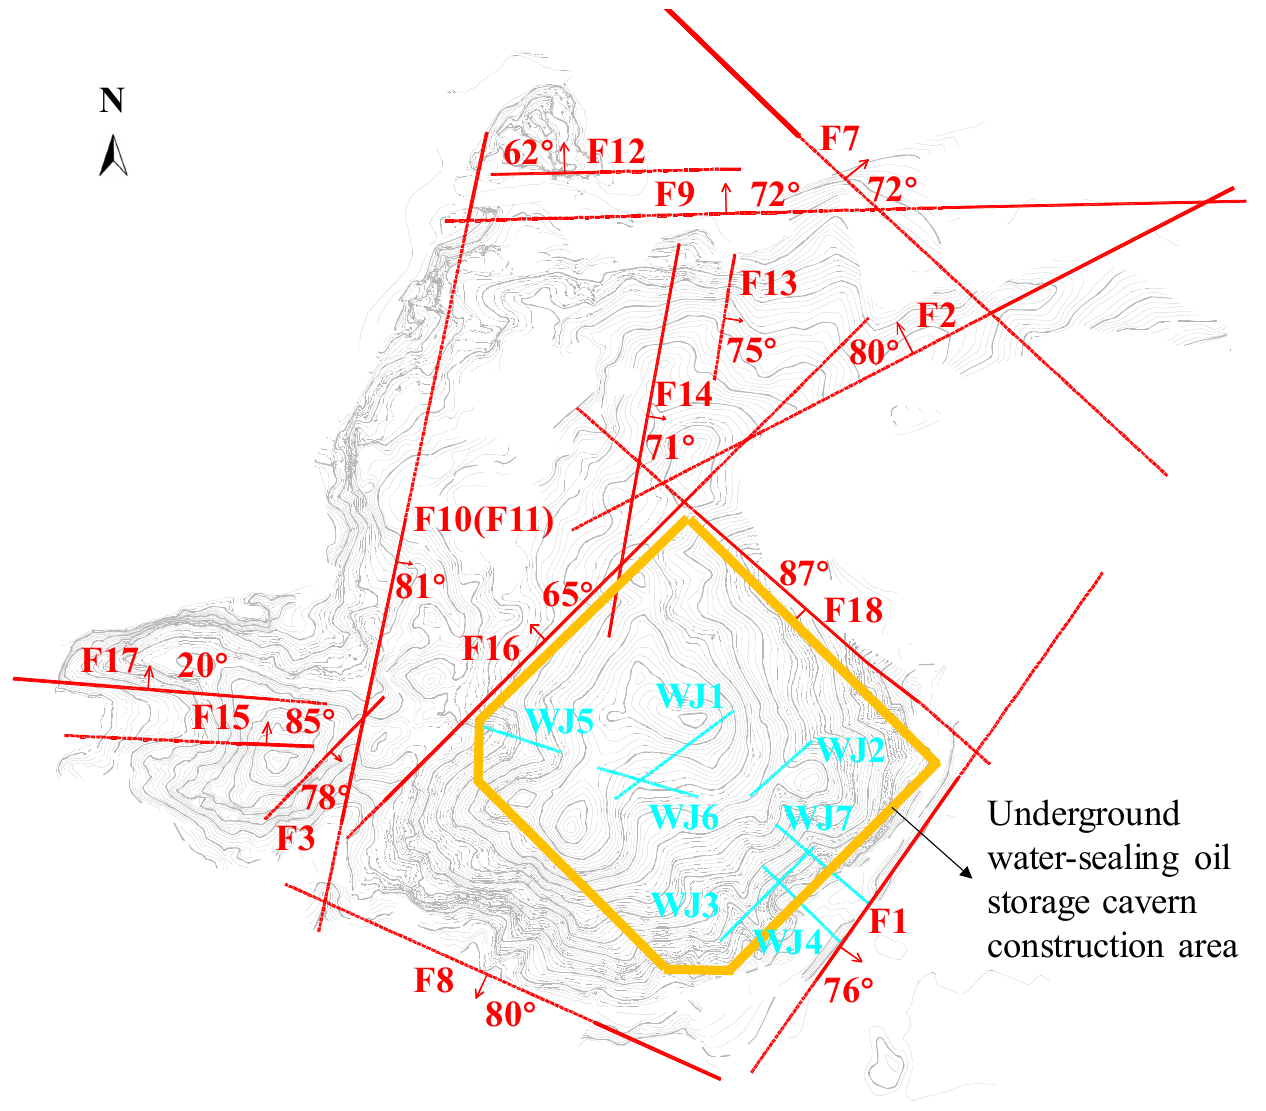
Figure 1. Faults and densely jointed zones in reservoir area.